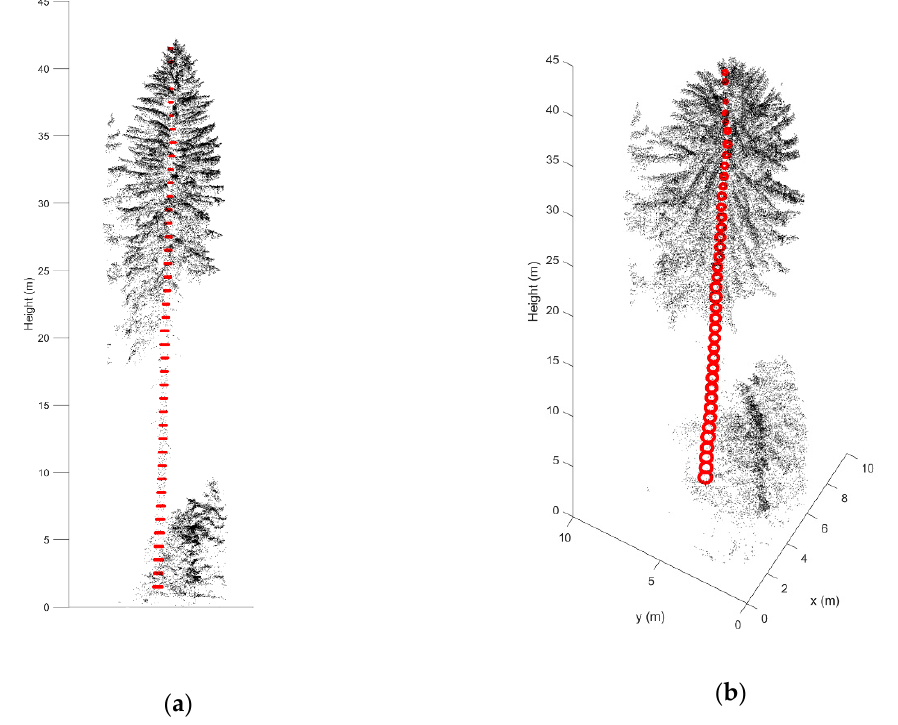
Figure 6. Automatically fitted perimeters of stem cross sections (red circles) in a point cloud representing automatically segmented spruce tree: ( a ) side view and ( b ) 3D view. The point cloud was thinned so that the fitted circles are visible in the figure.